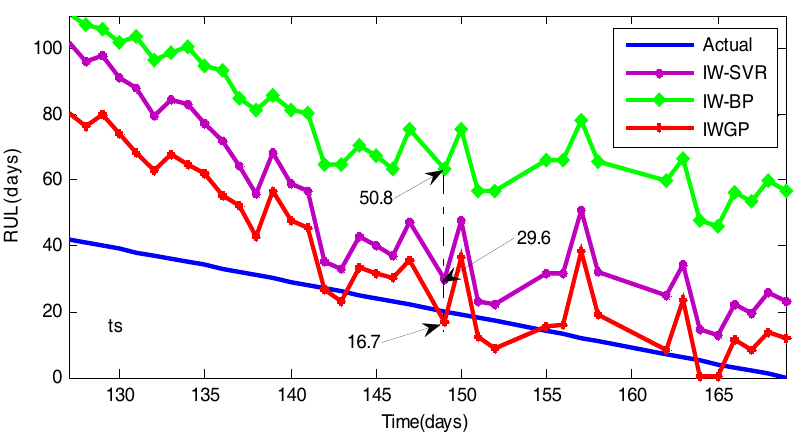
Figure 17. The prediction accuracy with different methods: the WI health indicators.